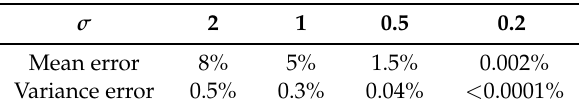
Table 2. Errors in mean and variance of approximation distribution P A given by (53) for ρ = 0.8 and various values of σ .